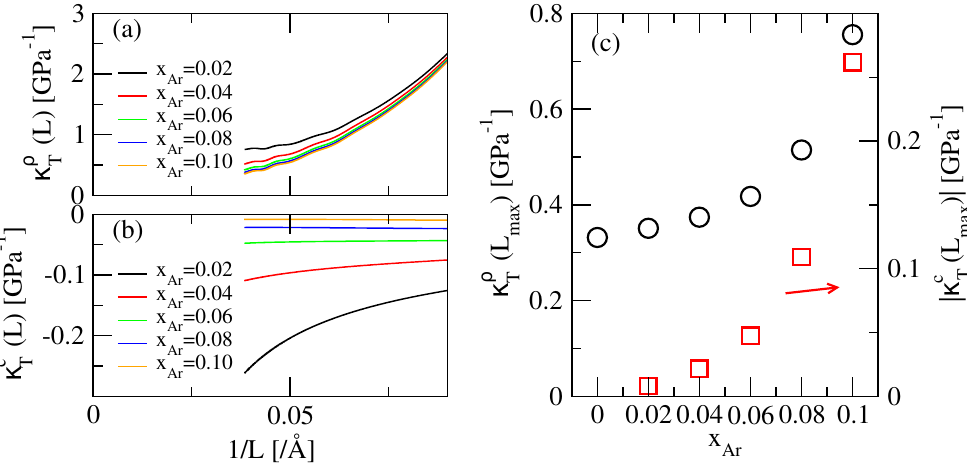
+ κ c , calculated for T T ( L ) (Equation (25)). T